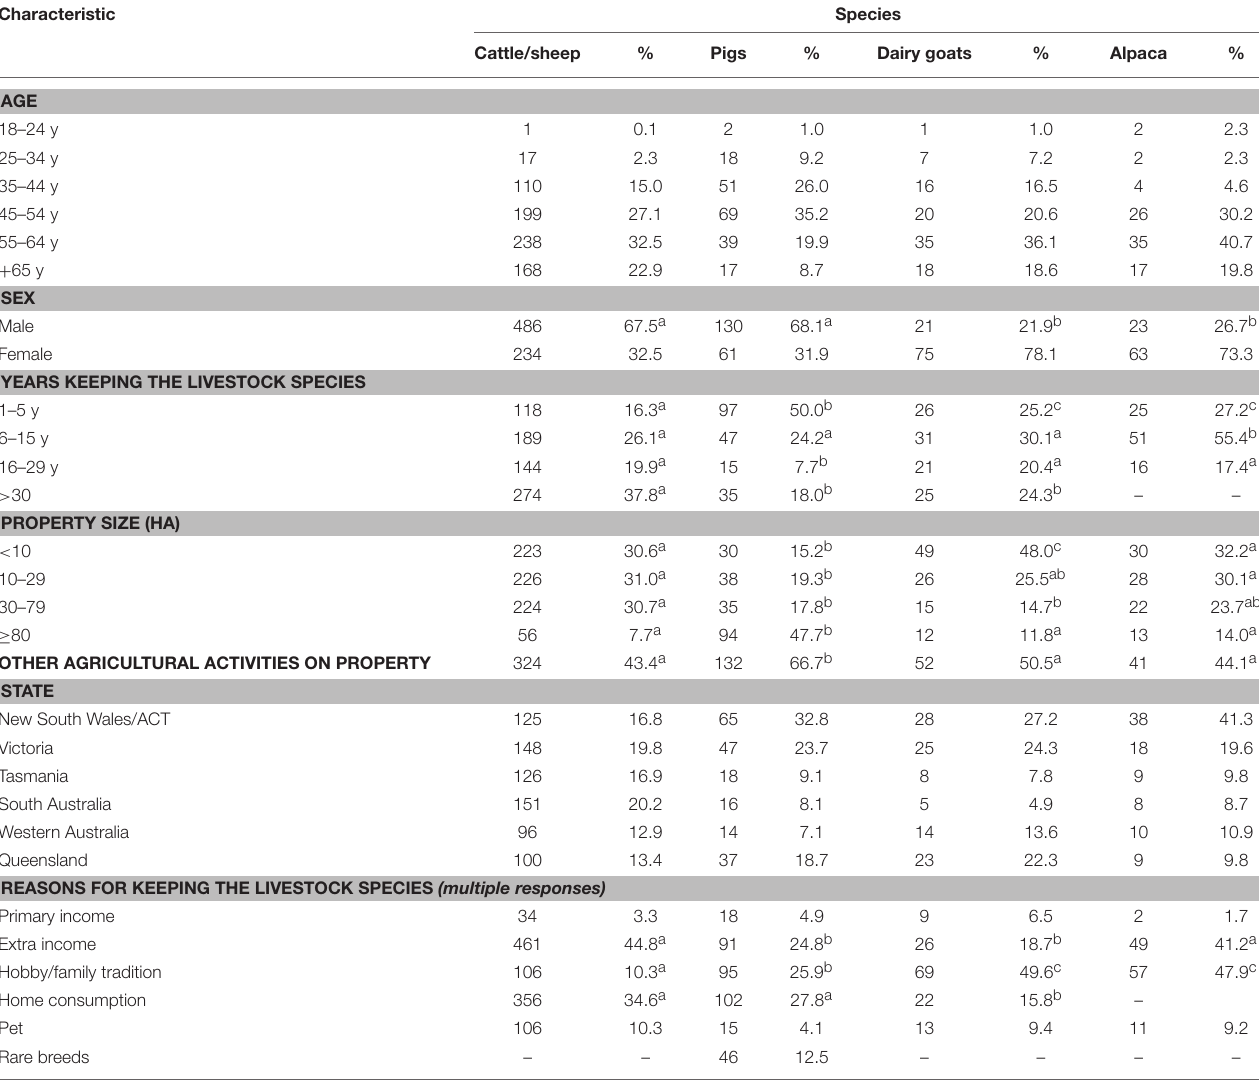
TABLE 1 | Demographic and husbandry characteristics of 1,140 smallholder livestock producers participating in a cross-sectional study in Australia in 2013–2015.